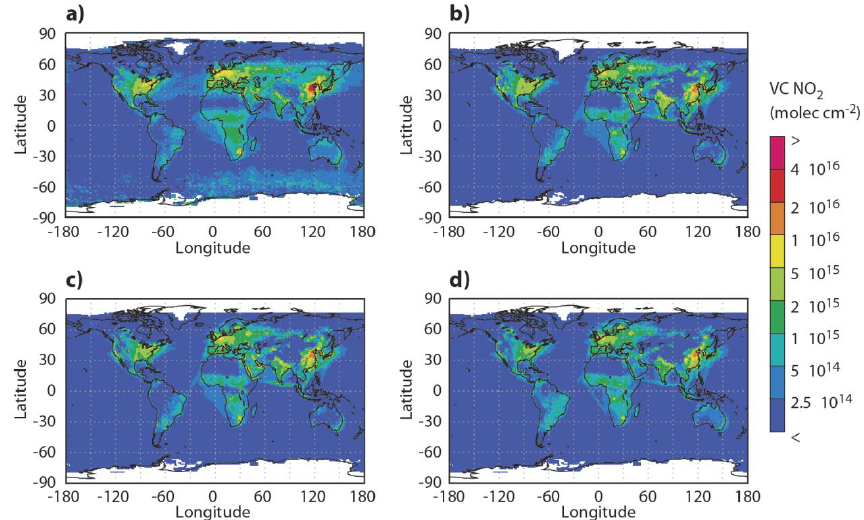
Figure 21. NO 2 tropospheric column retrievals for 2008 from (a) GOME-2, (b) CIFS-AN, (c) CIFS-CTRL and (d) REAN in 10 15 moleculescm − 2 . Red indicates higher values, blue lower values.